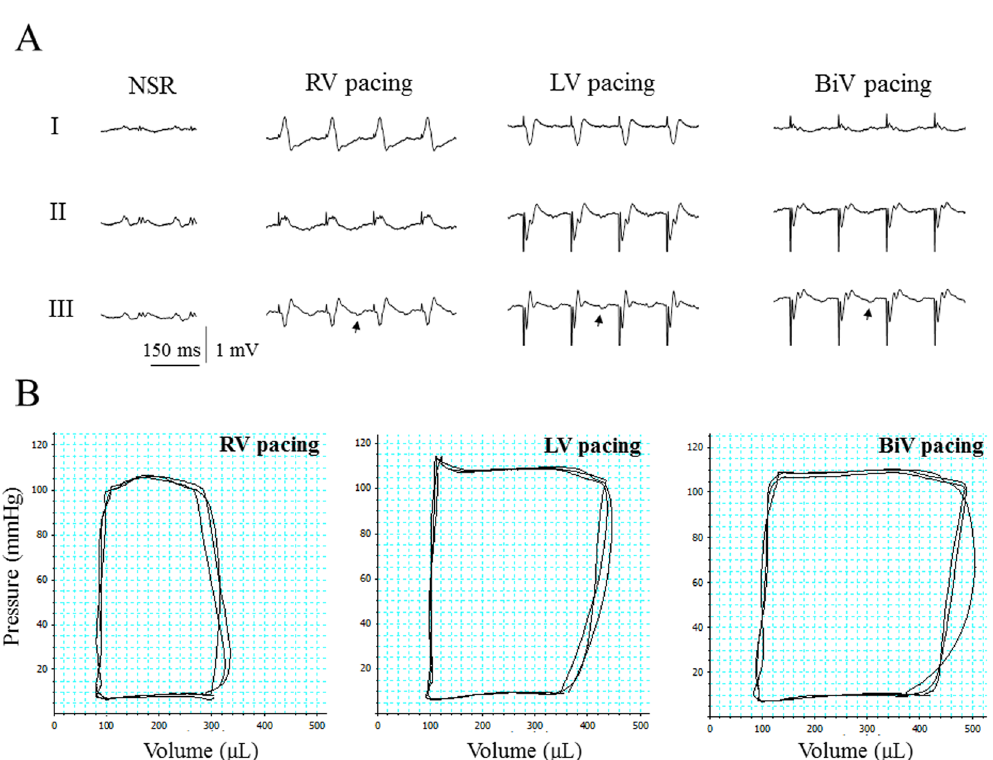
Figure 2. LV-based pacing modes markedly improve LV hemodynamic performance compared with RV pacing. Analysis of rats implanted with RV bipolar electrode and LV bipolar electrode. ( A ) ECG recordings during normal sinus rhythm (NSR) and the various ventricular pacing modes. Note LBBB like QRS pattern during RV pacing and a remarkable QRS shortening during BiV pacing. Note similar timing and morphology of the retrograde p-waves (marked by arrows), indicating that the component of AV-dyssynchrony is similar in all three ventricular modes of pacing. ( B ) PV-loop recordings during RV pacing, LV pacing and BiV pacing. Note the profound effects of LV pacing and BiiV pacing in comparison with RV pacing.